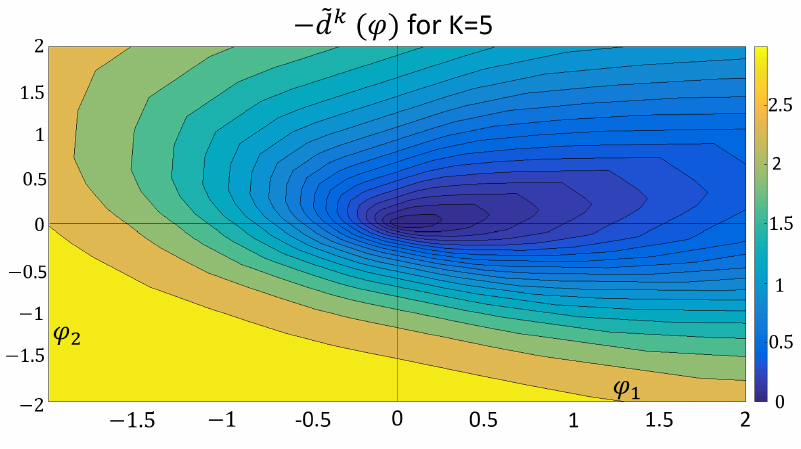
with K = 5 for T from Example downX